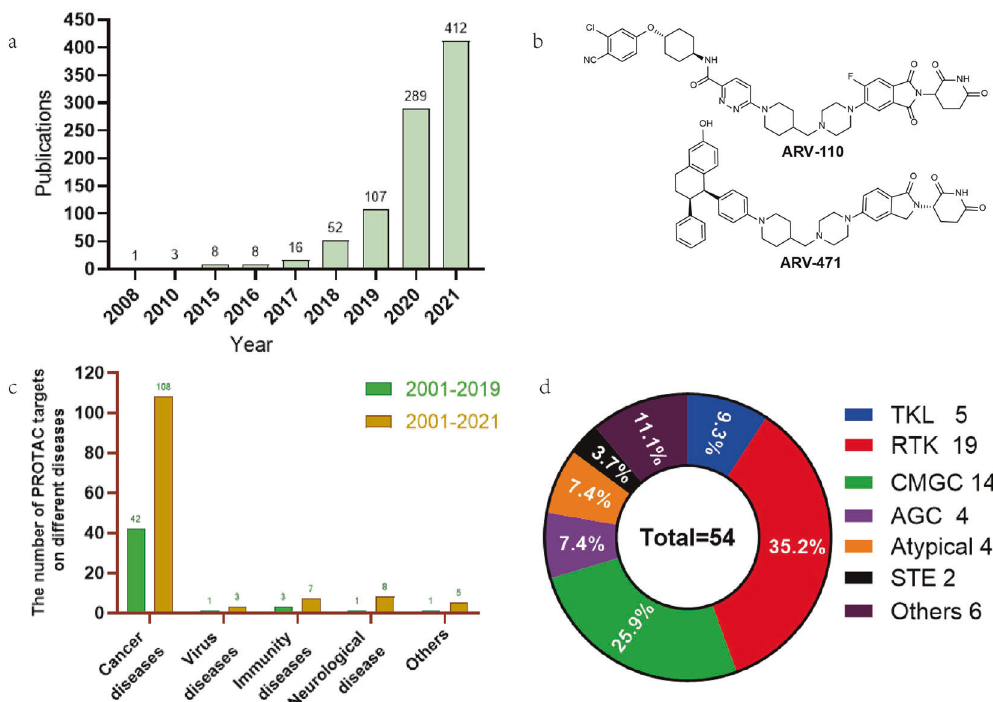
Fig. 2 The researches on PROTAC from 2001 to 2021. a The publications on PROTACs from 2001 to 2021. b The structure of ARV-110 and ARV- 471 . c The comparison of PROTAC targets on different diseases between 2001 – 2019 and 2001 – 2021. d Classi fi cation and percentage of degradable